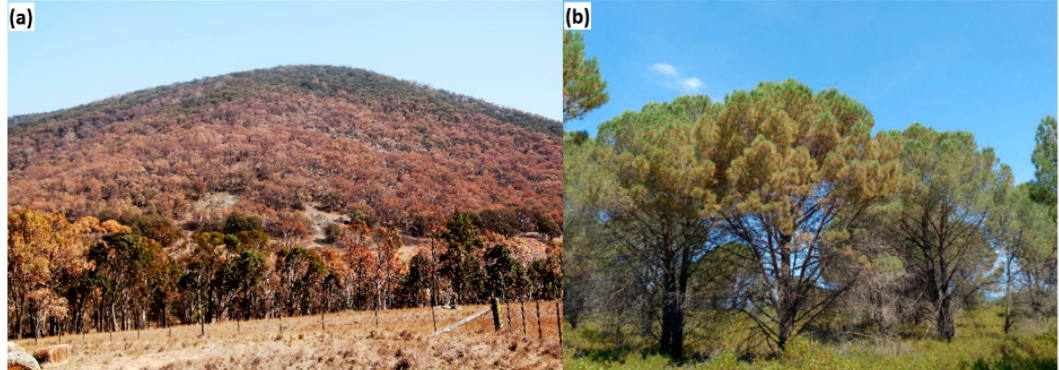
Figure 6 . ( a ) Eucalypt woodland in north-eastern New South Wales, Australia, during severe drought in October 2019, illustrating the conversion of live fuels (i.e., foliage) into dead fuels. In this region, over five million hectares was subject to wildfire in 2019/2020. ( b ) Seasonal needle senescence in Pinus halepensis in Catalonia, Spain. Several days following this photo (22 June 2019), large fires occurred nearby. Image credit: Carles Arteaga.